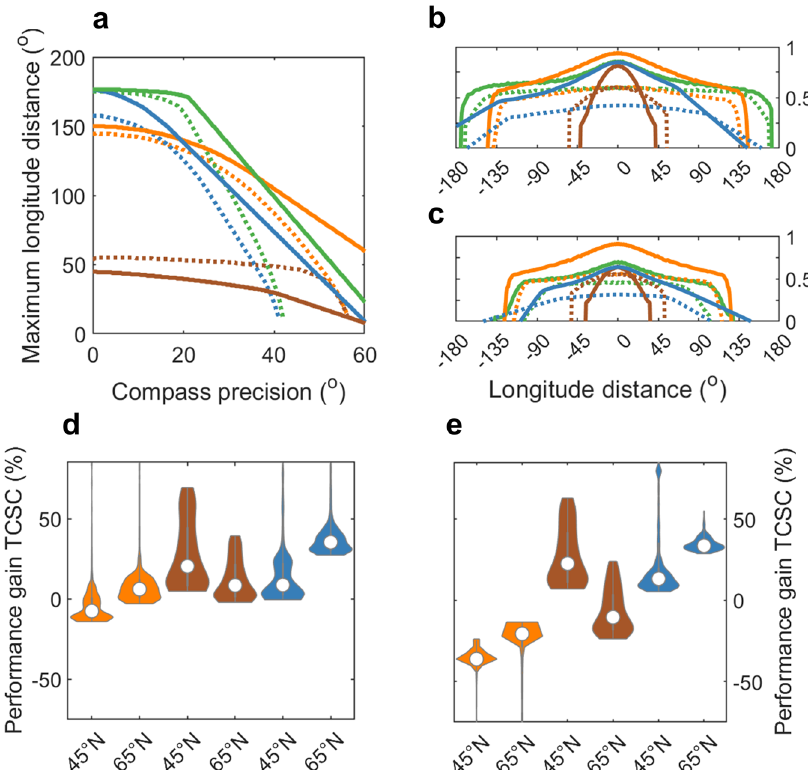
Fig. 5 Global migration ranges and compass-course performance for a generic migrant. Feasible longitude migration distances and relative performance among compass courses based on simulations for a generic nocturnally migrating species in a geomagnetic dipole Earth, with biologically relevant error (0° – 60° magnitudes in compass precision, and 15° drift). a Maximal longitudinal migration distances (with at least 25% success of arriving within 500 km of a goal) vs. compass precision (both in degrees), with line colours among compass courses as in Fig. 4 (orange: geomagnetic loxodrome, brown: magnetoclinic, blue: cue-transferred fi xed and green: cue-transferred TCSC courses). Solid lines represent migration between 45°N – 25°N and dotted lines between 65°N – 0°N. b and c Performance among compass courses with compass precisions of b 15° and c 30°, with solid lines representing migration between 45°N and 25°N and dotted lines between 65°N – 0°N. d and e Violin plots, with violin widths depicting distributions of percentage gain with TCSC relative to other courses among all feasible longitudinal distances for routes between 45°N and 25°N and between 65°N and 0°N, with colours matching a , and for compass precisions of ( d ) 15° and ( e )